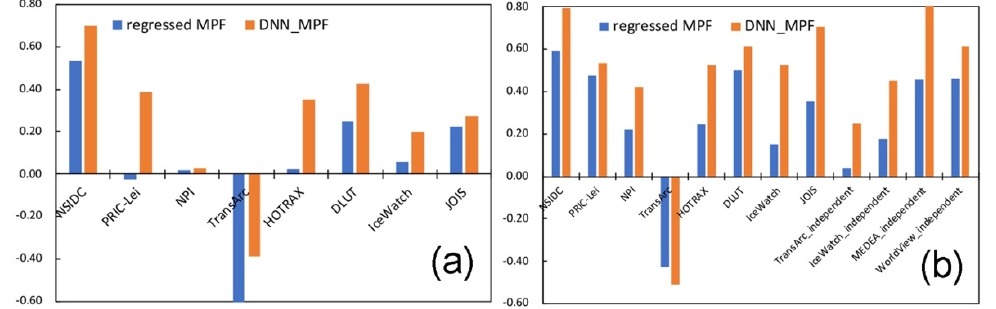
Figure 17. Correlation coefficients of the regressed MPF (regressed by surface reflectance) and DNN_MPF against the observed MPF in a ( a ) 500 m grid and ( b ) 12.5 km grid.